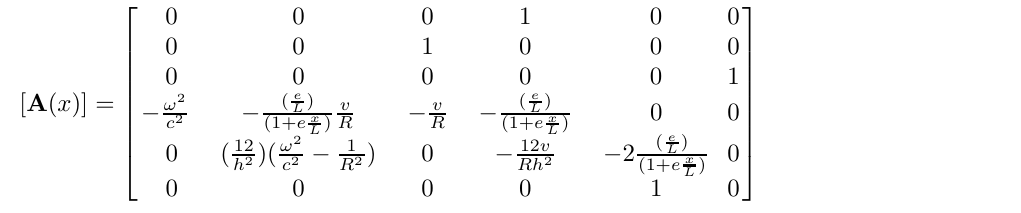
Fig. 8. Propagation constants of uniform (dash) and linear FGM (solid) shells (a) longitudinal direction, (b) radial